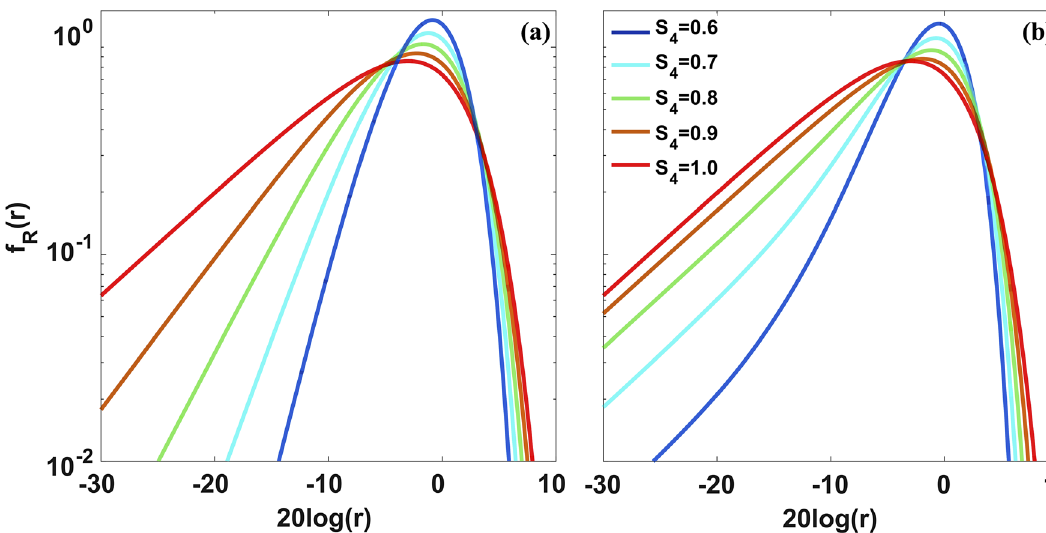
Fig. 4. Five shapes of density function for different values of S 4 for Nakagami- m model (a), and Rice model